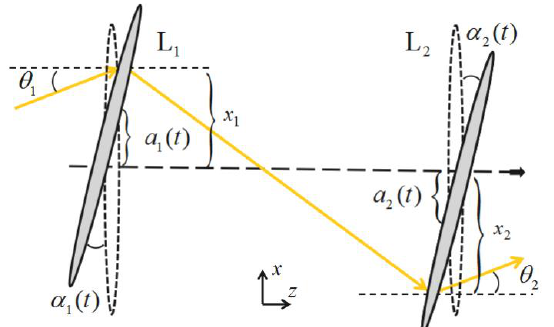
Figure 7. Transmission diagram of active control beam by the spatial filter of PW facility.